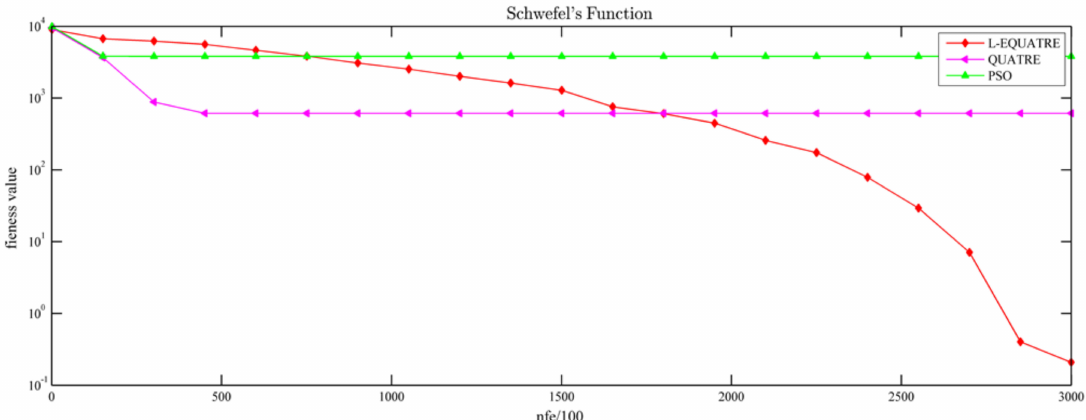
Figure 5. Schaffer’s function.